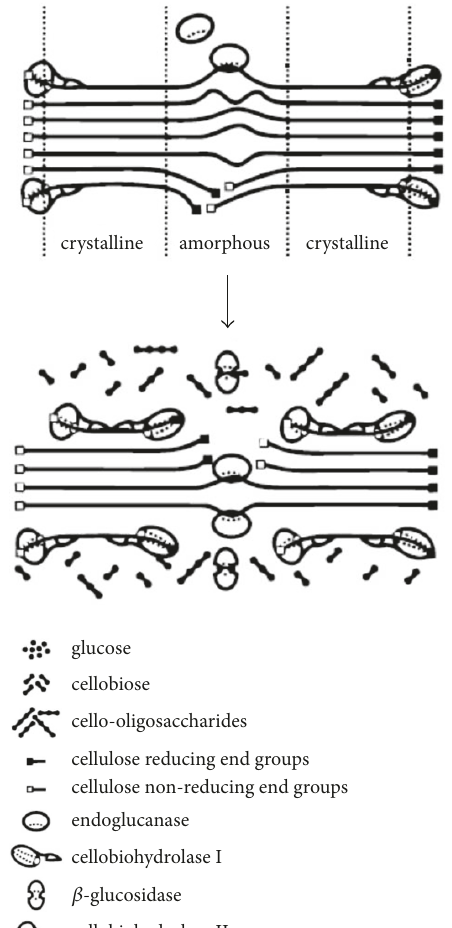
Figure 5: Schematic diagram of different cellulase impacts on cellulose, adapted from